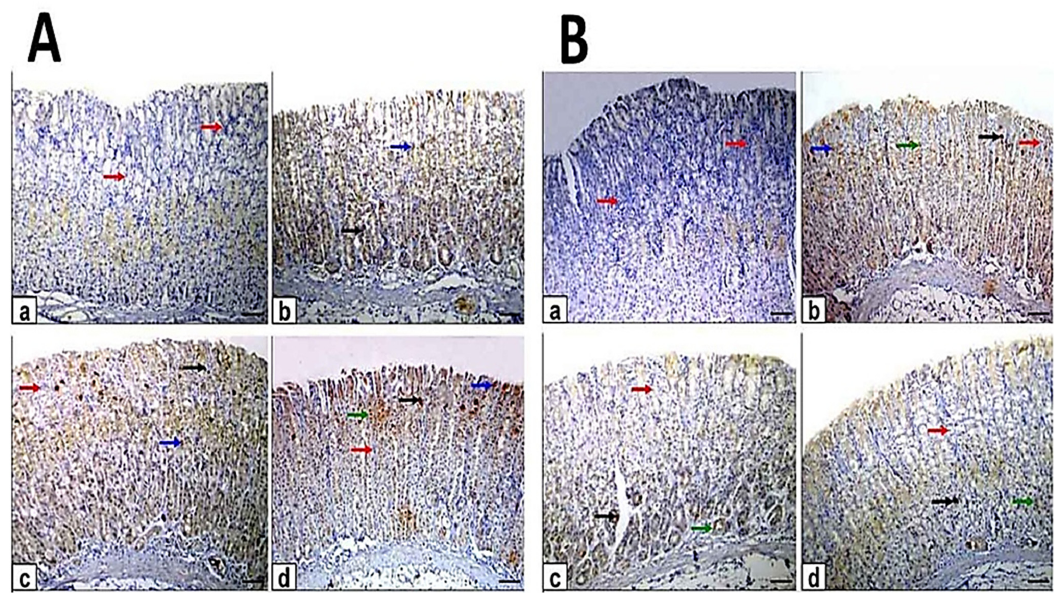
Figure 6. Photomicrographs of immunohistochemical staining of caspase-3 protein expression in gastric sections. Scale bar = 100 µm. ( A ) The gastric sections of the pretreatment group: ( a ) control rats, ( b ) ethanol-induced ulcer rats in one hour, ( c ) MO-pretreated (MO-EtOH) rats, ( d ) ME-pretreated (ME-EtOH) rats. Arrows in the panels are showing strong (black arrows), moderate (blue arrows), weak (green arrows), and negative (red arrows) brown immunoreactions. ( B ) The gastric sections of the treatment group: ( a ) control rats, ( b ) ethanol-induced ulcer rats on day 7, ( c ) MO-treated (EtOH-MO) rats, ( d ) ME-treated (EtOH-ME) rats. Arrows in the panels showed strong (black arrows), moderate (blue arrows), weak (green arrows), and negative (red arrows) brown immunoreactions.